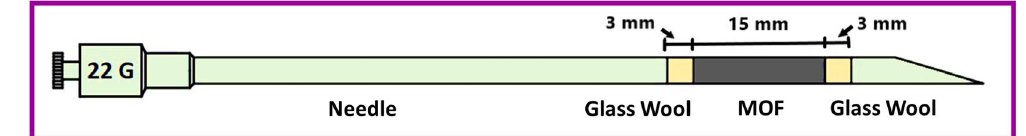
Figure 1. Schematic diagram of a packed needle with Zr-UiO-66-PDC adsorbent for headspace sampling of amphetamine compounds.